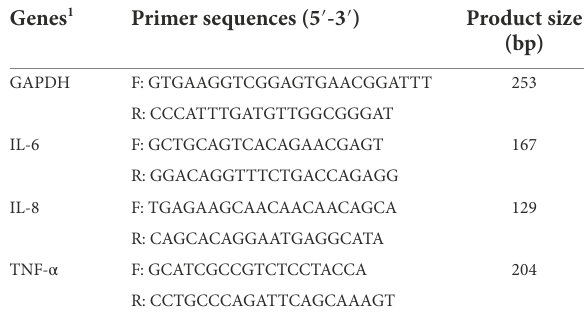
TABLE 1 Primers used for